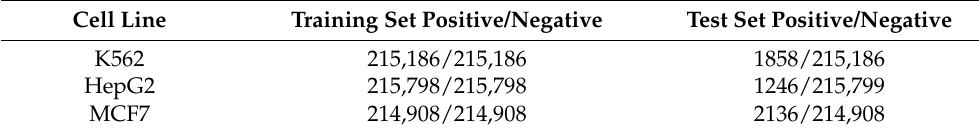
Table 2. Training set and test set sizes of experiments for each cell line. Cell